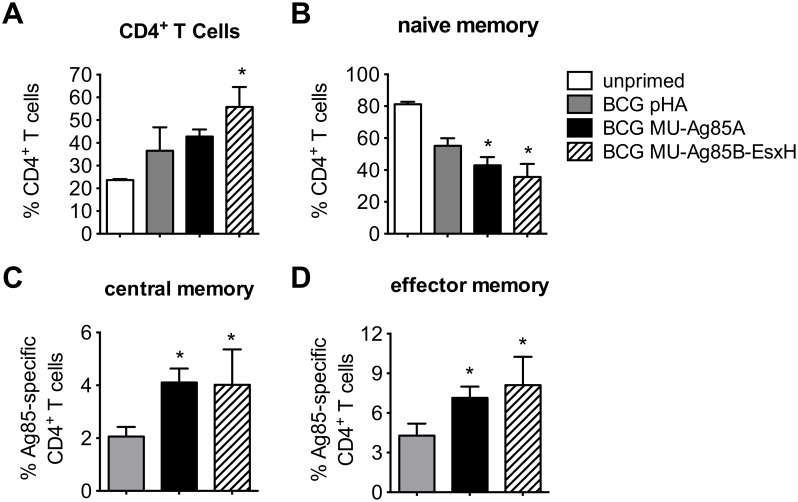
BCG MU-Ag85B-EsxH induces replication of antigen-specific CD4+ effector and central memory T cells.At 4 weeks post-prime with empty-vector BCG (gray), BCG MU-Ag85A (black), or BCG MU-Ag85B-EsxH (striped), mice were bled retro-orbitally and peripheral leukocytes were stained CD4 and the memory markers CD62L and CD44. Percentages of total CD4+ T cells (A) and CD62LloCD44lo naïve CD4+ T cells (B) were quantified, as were antigen-specific effector memory CD4+ T cells (CD62LloCD44hi) and central memory CD4+ T cells (CD62LhiCD44hi) which specifically bound Ag85-MHCII-tetramer (C, D). Asterisks indicate statistical analysis by the student’s t-test (n = 4 for each group). Error bars represent standard deviation. *p<0.05.